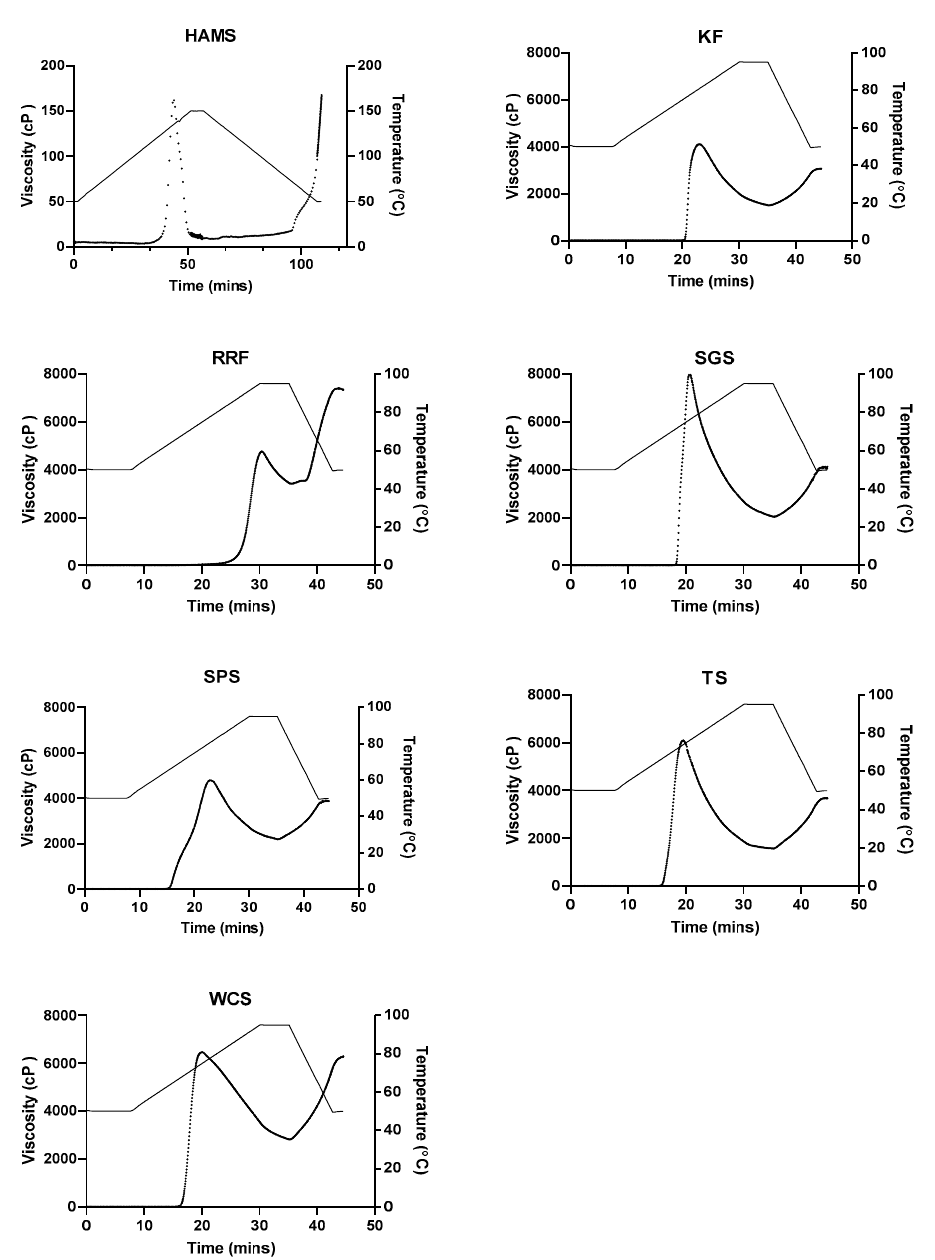
Figure 2. The pasting profiles of 10% w / w starch or flour suspensions. The viscosity curve is denoted by ● , plotted on the left axis; while the temperature curve is denoted by ꟷ , plotted on the right axis. HAMS—high amylose maize starch, KF—kithul flour, RRF—red rice flour, SGS—sago starch, SPS—sweet potato starch, TS—tapioca starch and WCS—water chestnut starch.